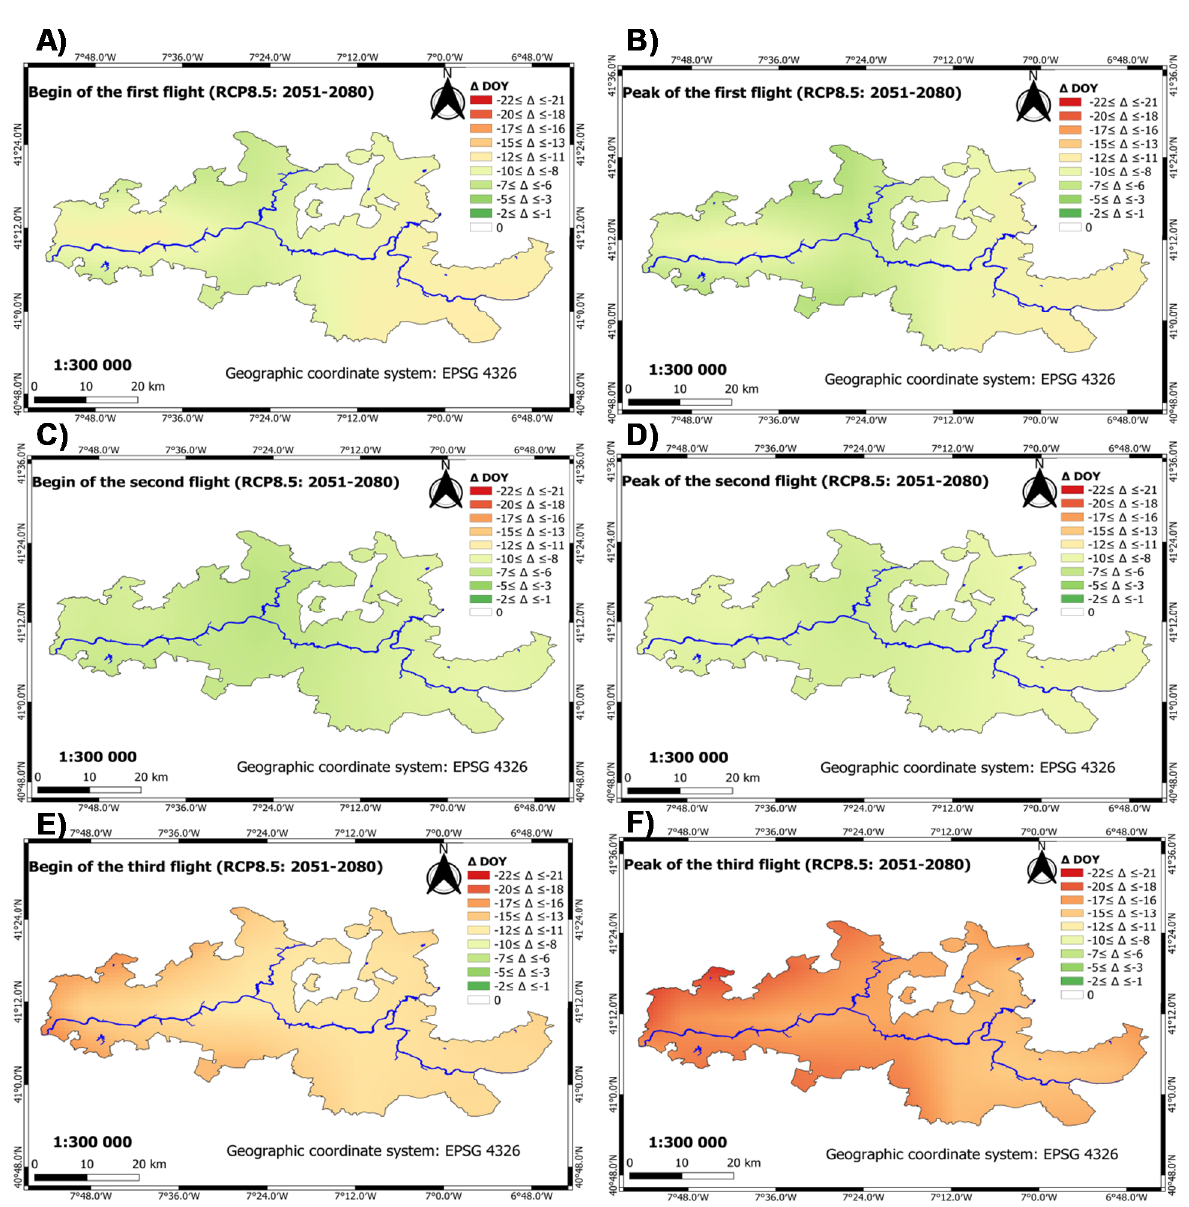
Figure 5. Difference between future and historic (RCP8.5) phenology maps covering the entire Douro Demarcated Region. The color scale shows the difference between future and historic (Δ DOY) for each beginning (left) and peak (right) of the first ( A , B ), second ( C , D ) and third ( E , F ) flights. In addition, the Douro river and main tributaries are also outlined (thick blue line).